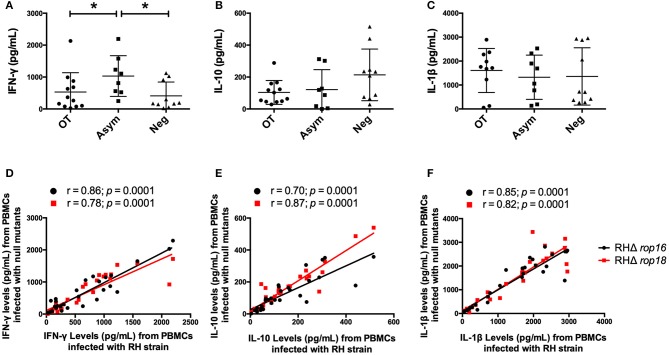
Cytokine secretion by PBMCs infected with the RH strain of T. gondii. The concentration of IFN-γ (A), IL-10 (B), and IL-1β (C) were determined by ELISA in supernatants at 24 h post-infection (h.p.i.). A correlation analysis on RH, RHΔrop16 and RHΔrop18 strains for each cytokine was performed. The x axis indicates the concentration of IFN-γ (D), IL-10 (E), and IL-1β (F) for RH infections. The y axis indicates the same cytokine as in x axes for RHΔrop16 (black circles) or RHΔrop18 (red squares) T. gondii infected cells. Each point represents the concentration of cytokines of a single patient. Results (A–C) are represented as mean ± SD; *p < 0.05, Mann-Whitney U test and the correlations were determined by Spearman's correlation tests. OT, Ocular toxoplasmosis; Asym, Chronic asymptomatic infection; Neg, T. gondii seronegative individuals.